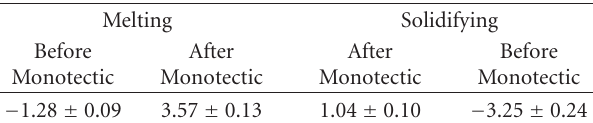
Table 6: Volume change of the Cu-5Sn-5Pb alloy during melting and solidification in term of percentage at a cooling rate